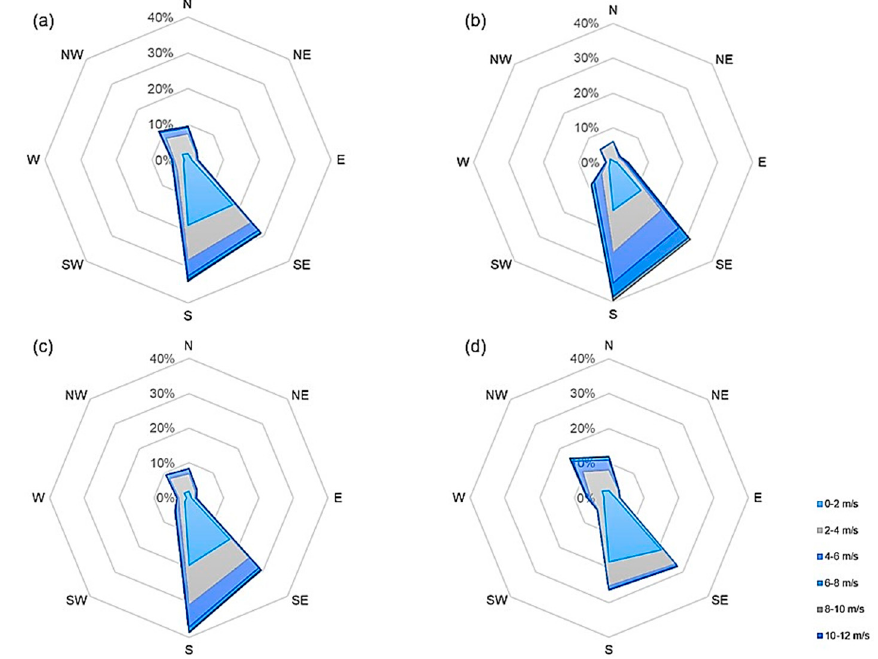
Figure A2. Wind rose during the measurement campaign in 2020 at the location Schorndorf for the periods ( a ) total: 18.03–13.05, ( b ) pre-flowering: 18.03–25.03, ( c ) main flowering: 25.03–22.04, ( d ) post-flowering: 22.04–13.05.